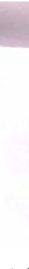
Figure 3. Specially made tip for Universal Testing Machine.